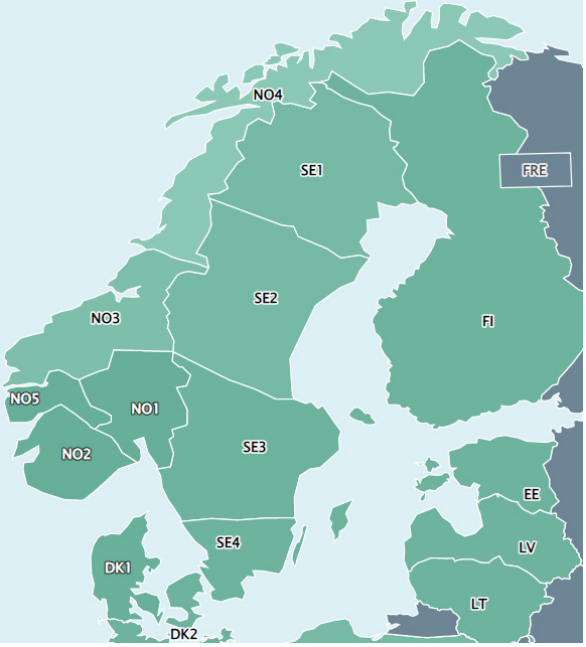
Figure 8. Price area distribution of Nordic electricity market.